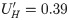
These locally optimal solutions are a sample of the diverse gaits possible with the model.Each stick figure is a snapshot from a different part of the gait cycle. The first still (leftmost, purple) is at touchdown of the left hindlimb. Each still is separated from the next in time by one tenth of the stride time, culminating at the next left-hind touchdown. The “x” marker represents center of mass location. At both a walking speed of UH′=0.39 (A-D) and running speed of UH′=1.1 (E-H), asymmetric (A,B,E,F) and symmetric gaits (C,D,G,H) are possible. y-axis and x-axis scales are equal.